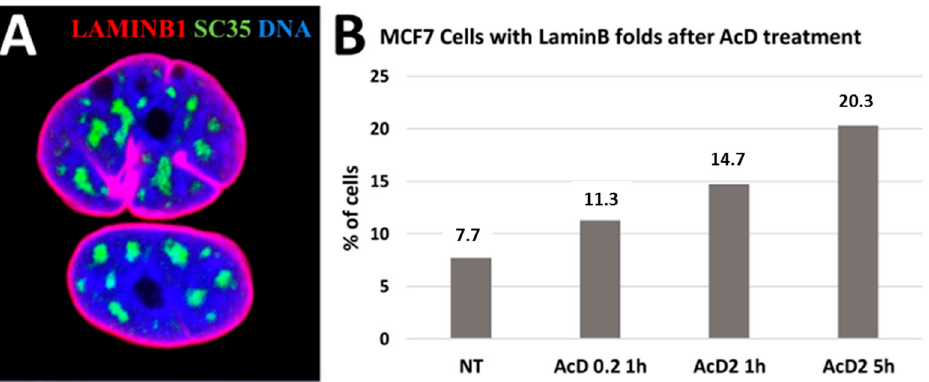
Figure 13. Softening of nuclear lamin testified as an increase of the proportion of cells with intranu- clear lamin folds in the time course of suppression of RNA synthesis; ( A ) Nucleus without and with lamin B1 (evidenced by IF staining of lamin B1 (red) invaginations; ( B ) Counts of nuclei with lamin B1 invaginations after AcD treatment. (Note: This figure was originally published under CC-BY license in [62]).